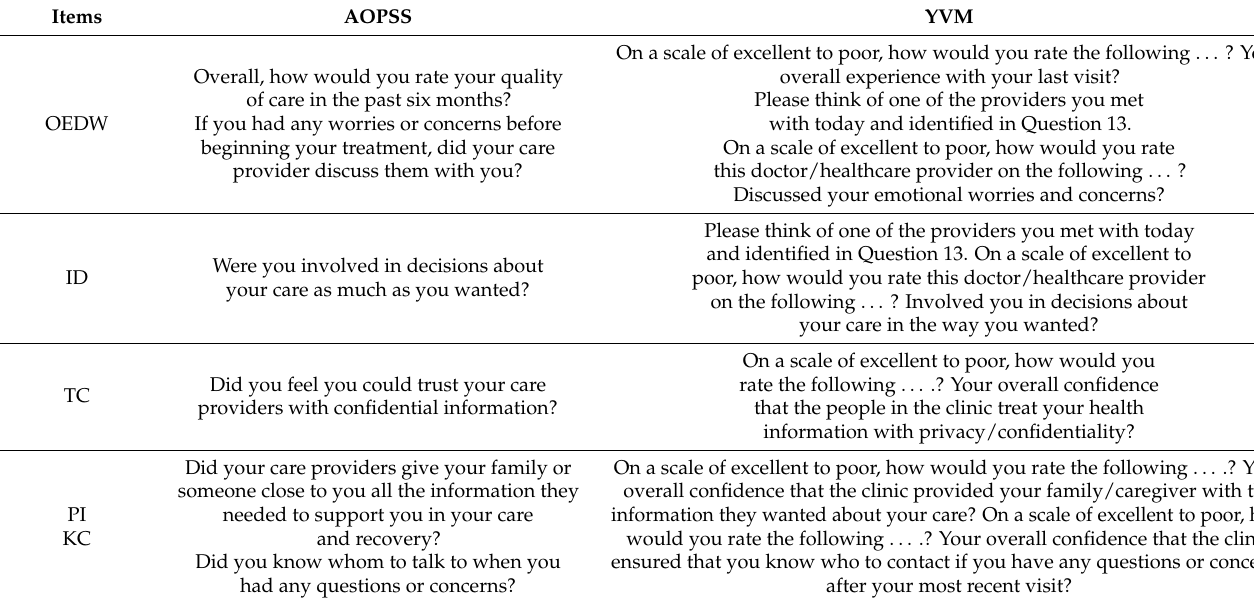
Table 2. Experience questions that were compared between the AOPSS and the